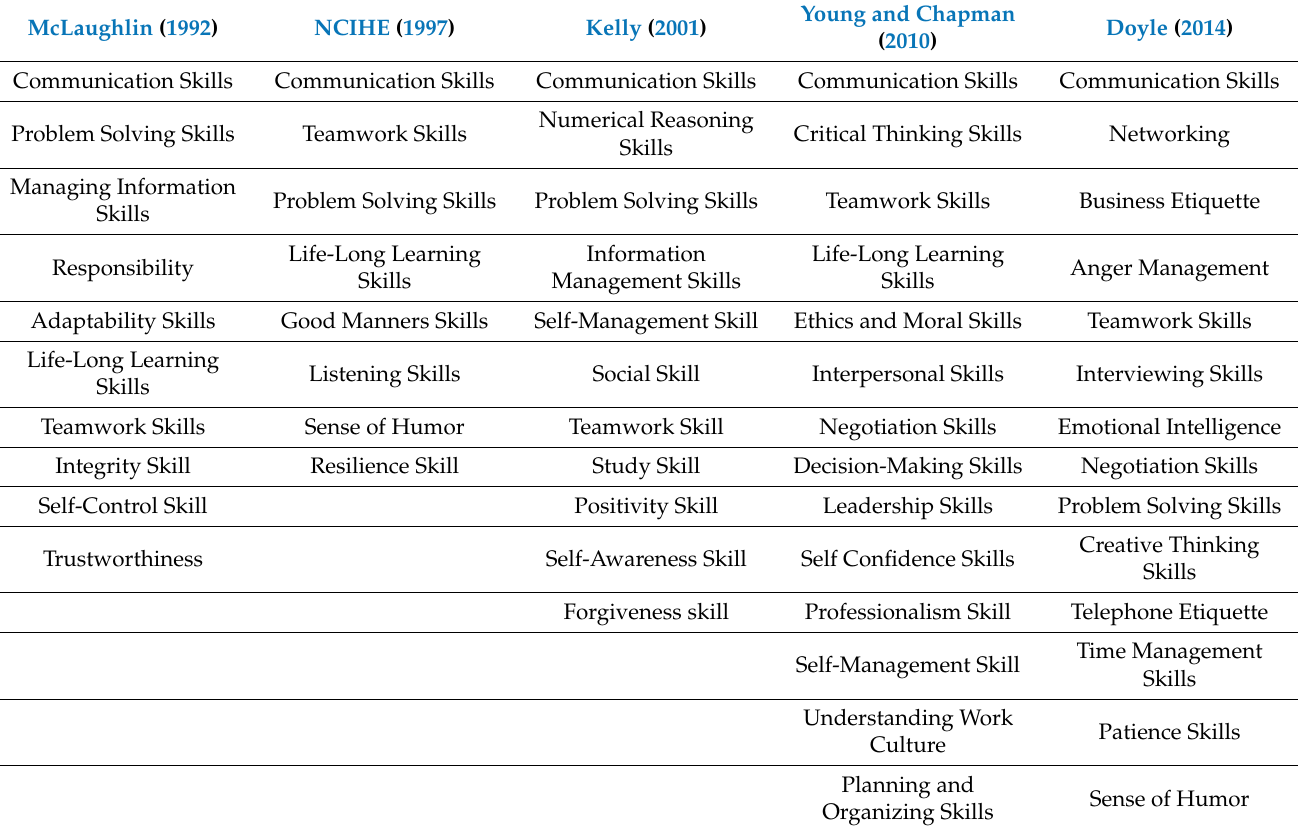
Table 1. Soft skills as progressively identified by previous